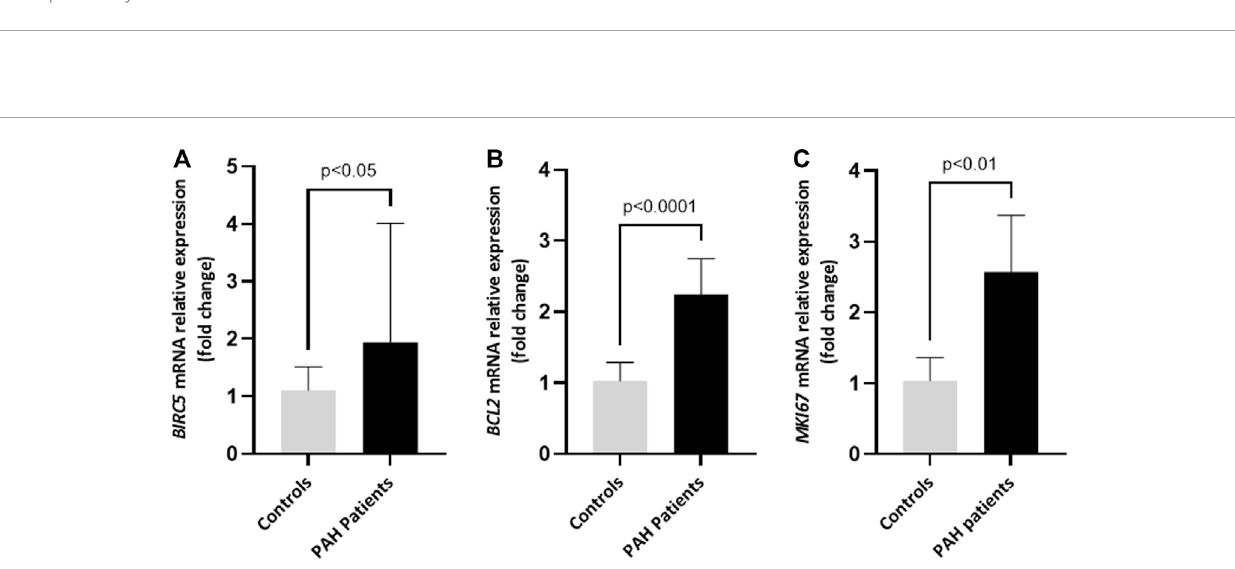
FIGURE 8 mRNA expression of survivin and genes involved in apoptosis and proliferation in whole lung extracts of patients with PAH. Quantitative RT-PCR assay of the mRNA expression of BIRC5 , the gene encoding survivin (A) , BCL2 (B) and MKI67 (C) in lung explants from patients with PAH compared with control lungs. BIRC5 values are expressed as median (IQR) and statistical signi fi cance was assessed by the U-Mann Whitney test. BCL2 and MKI67 values are expressed as mean ± SD and statistical signi fi cance was assessed by the two-tailed Student´s